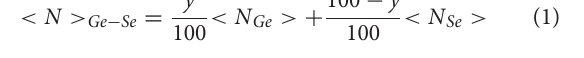
Figure 7 (blue symbols), can be taken as linear